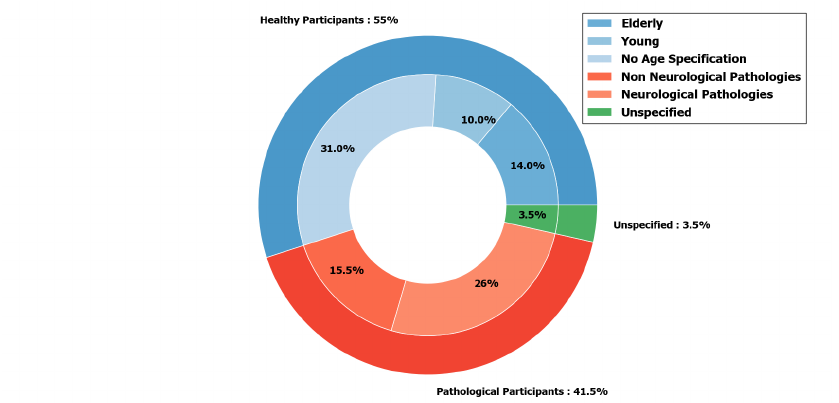
Figure 12. Distribution of studies according to participants state of health of participants. In shades of blue are represented the proportion of studies with non-ill participants (in light blue those with young participants, in intermediate blue those with elderly participants). The proportion of studies with ill participants is shown in shades of red. A distinction is made between neurological (dark red) and non-neurological (light red)